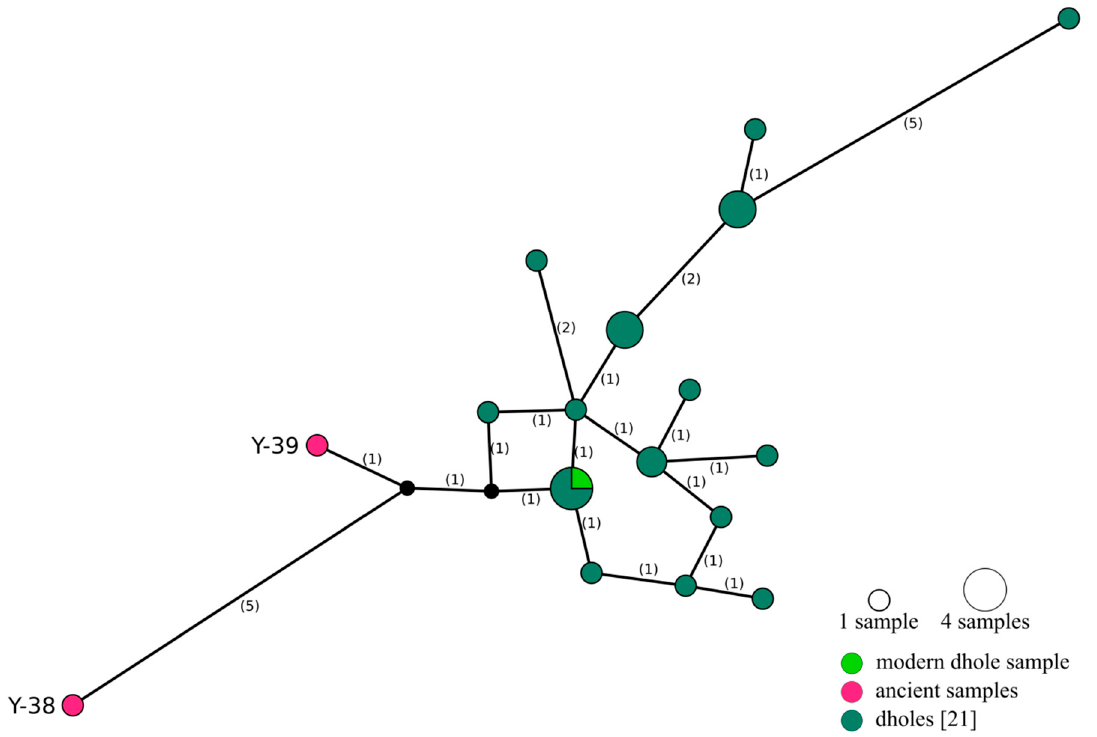
Figure 3. Median-joining network of a 170 bp long mitochondrial fragment of 25 dhole sequences. Number of mutations given in brackets. Red: ancient samples, light green: modern dhole sample, dark green: published dhole sequences [21], black: inferred (unsampled)